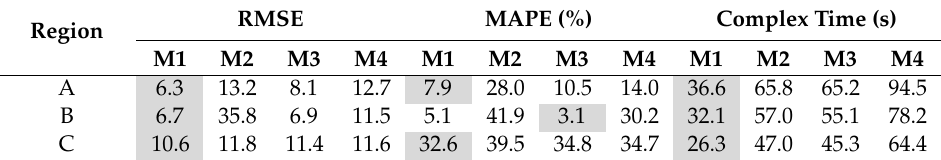
Table 4. Comparison of results obtained using Models in A, B, and C Regions of Jeju Island. Region